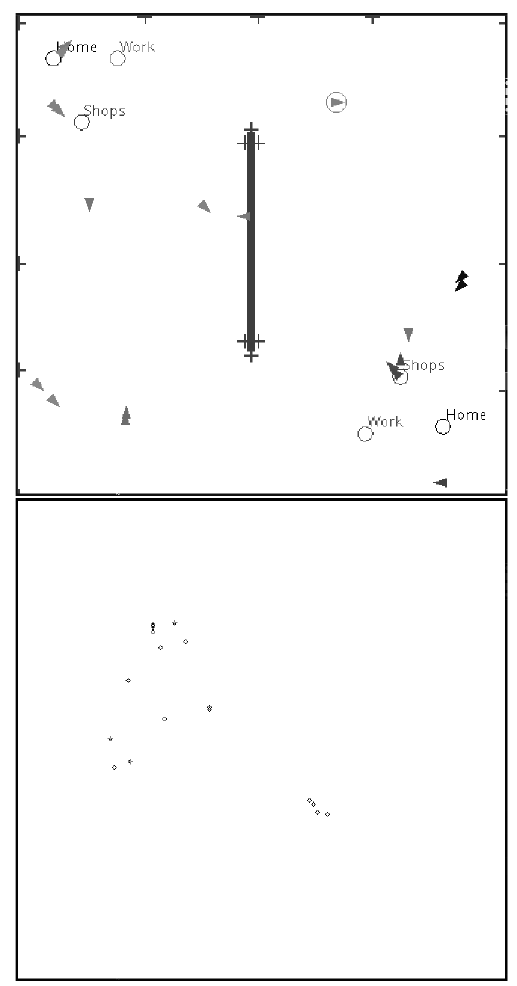
Figure 9. Agents (triangles on left-sided picture) and their signatures (dia- monds on right-sided picture). Signatures being considered as a two- coordinate vector can be projected on the same physical space as agents, which shows where emerged subgroups of agents spend most of their time. The geographical proximity of the agents signa- tures is a way to define the emergence of subgroups of agents. Here for instance, one can distinguish two main subgroups, on each side of the vertical “wall”; right subgroup is more tightened than left one, which is not yet